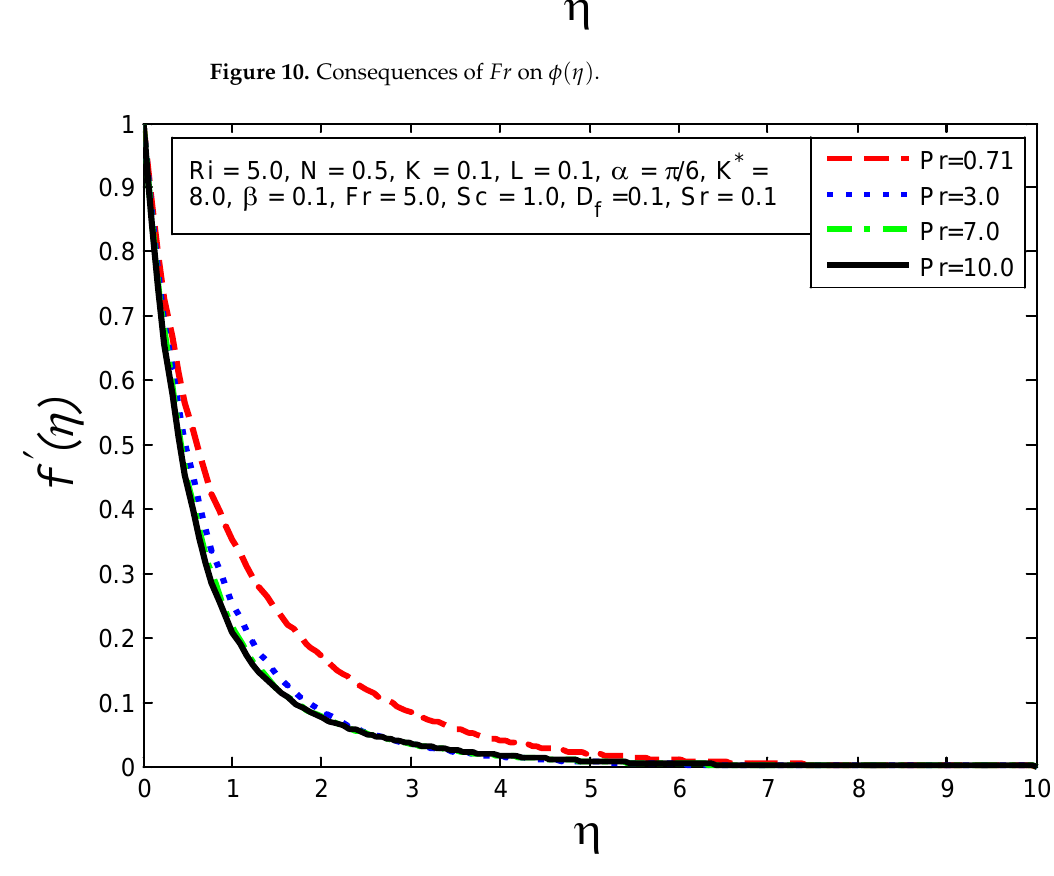
Figure 10. Consequences of Fr on φ ( η ) .